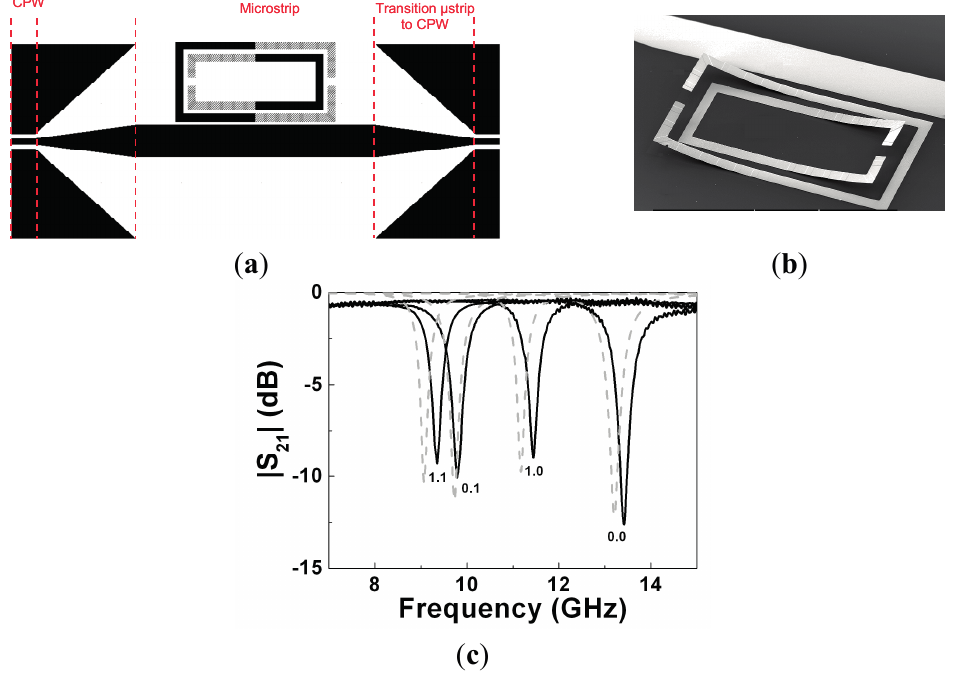
Figure 12. Topology of the tunable SRR coupled to a microstrip line with microstrip to coplanar waveguide transition ( a ), photograph of the non-actuated SRR ( b ), and measured (solid lines) and simulated (dashed lines) frequency response of the structure for the four different states ( c ). The separation between the SRR and the microstrip line is 50 μ m, and the width of the microstrip line is 400 μ m. The applied voltage for either ring actuation is 30 V. The state of the rings is indicated, where ‘1’ (ring actuation) stands for down state and ‘0’ for up state, and the first bit corresponds to the inner ring. From [22], reprinted with